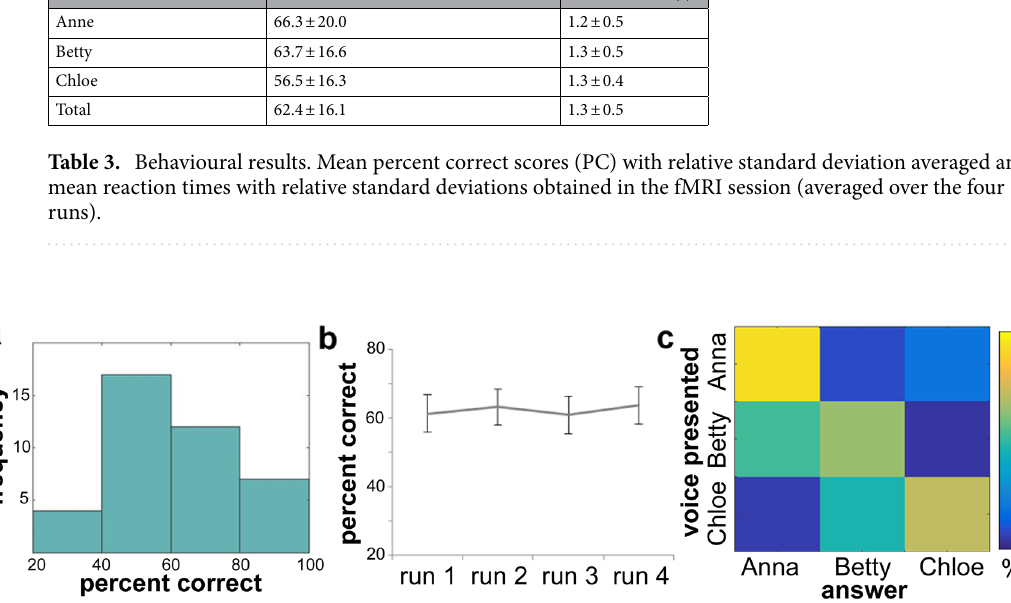
Figure 2. Behavioural performance during the fMRI session. a. distribution of the scores obtained in the scanner (N = 40); b. mean performance across the four runs. Error bars represent 95% confidence interval. c. Confusion matrix of presented voices vs. answers. Colorscale indicates proportion of trials corresponding to each Presented voice-Answer pair. The sum of the 9 cells is 100%; random performance would be 11.11% in each cell; perfect performance would be 33.33% in each cell of the diagonal and zero